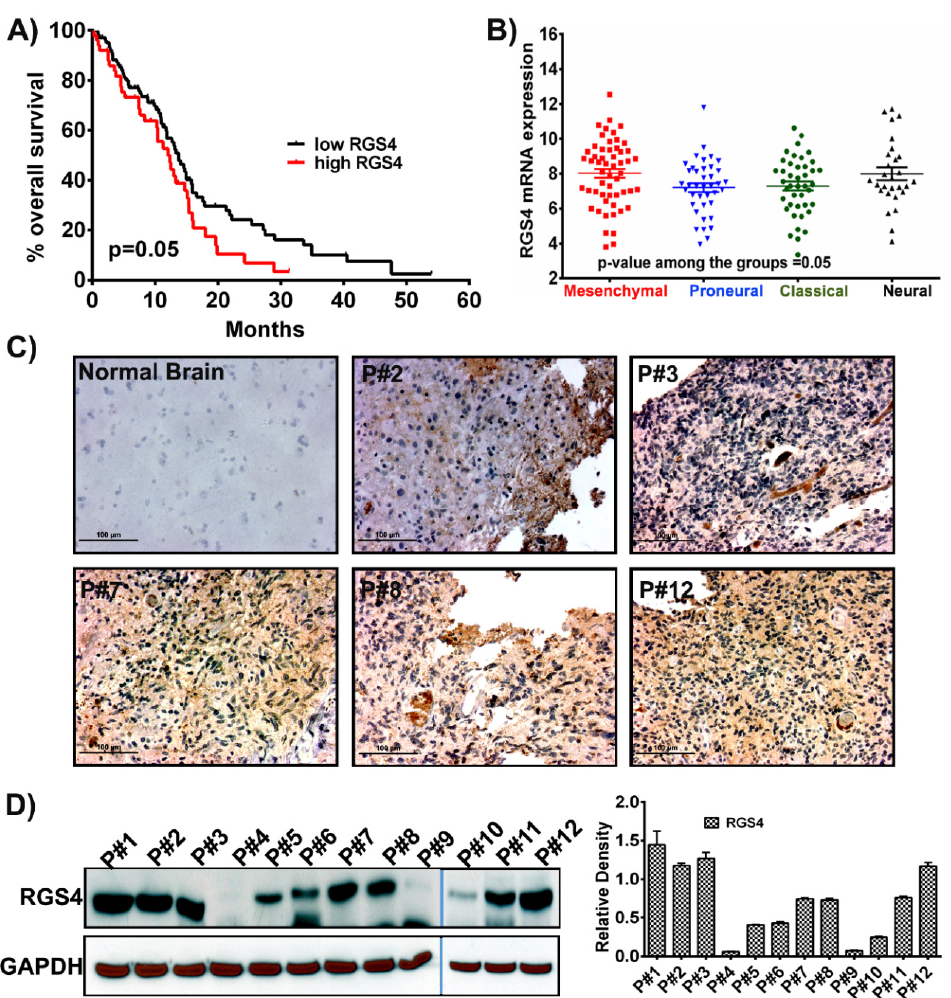
Figure 1. RGS4 expression in glioblastoma samples. ( A ) Kaplan–Meier curve plotted from the data obtained from The Cancer Genome Atlas (TCGA) shows that increased regulators of G-protein signaling 4 (RGS4) expression corresponds to decreased survival ( n = 172). p -value is calculated by log rank test ( p = 0.05). ( B ) The mRNA expression levels of RGS4 plotted in di ff erent subtypes of glioblastoma ( n = 163; mesenchymal = 42; proneural = 55; classical = 27; neural; = 39). The error bars are plotted based on the standard error of mean (SEM). ( C ) Immunohistochemical staining for RGS4 with anti-RGS4 antibody (brown, diaminobenzidine; light blue, nuclear counter stain with 4 ′ ,6- diamidino-2-phenylindole (DAPI); P = glioblastoma specimen) showed positive staining in the glioblastoma (GBM) patient specimens. Negative staining is observed in the normal brain sample specimen (Bar = 100 µ M). ( D ) Immunoblot analysis of RGS4 expression in di ff erent patient samples (human GBM (hGBM) patient samples = 12). GAPDH (Glyceraldehyde 3-phosphate dehydrogenase) is used as a loading control. The density levels were quantified and represented as a bar